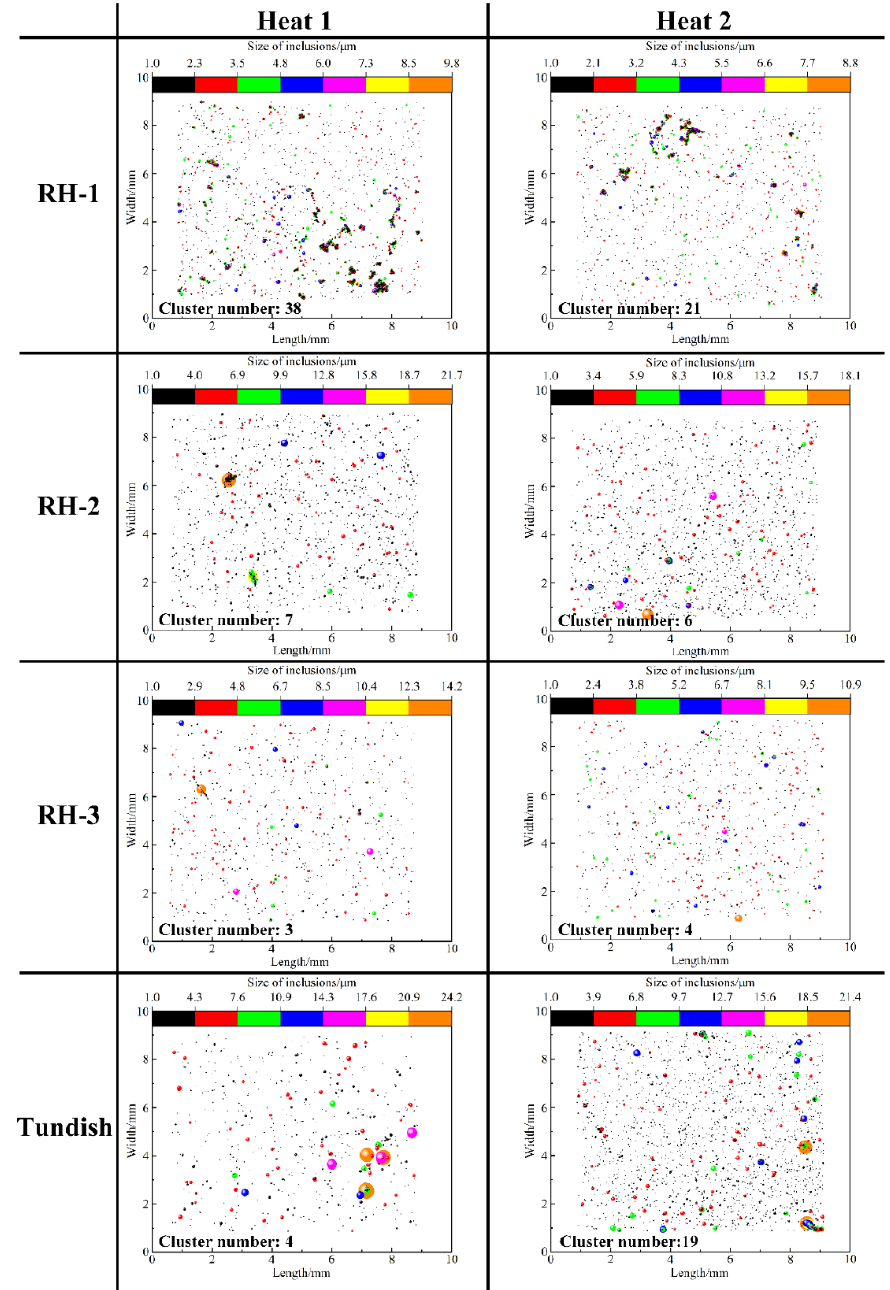
Figure 6. Distribution of inclusions in the total sample detection area for Heat 1 and Heat 2 during RH treatment and tundish